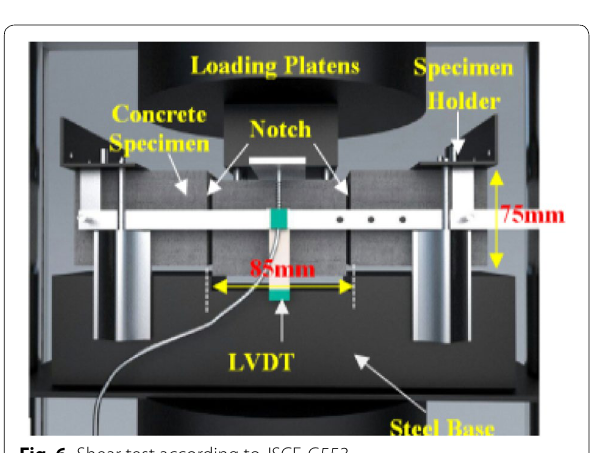
Fig. 6 Shear test according to JSCE-G553.